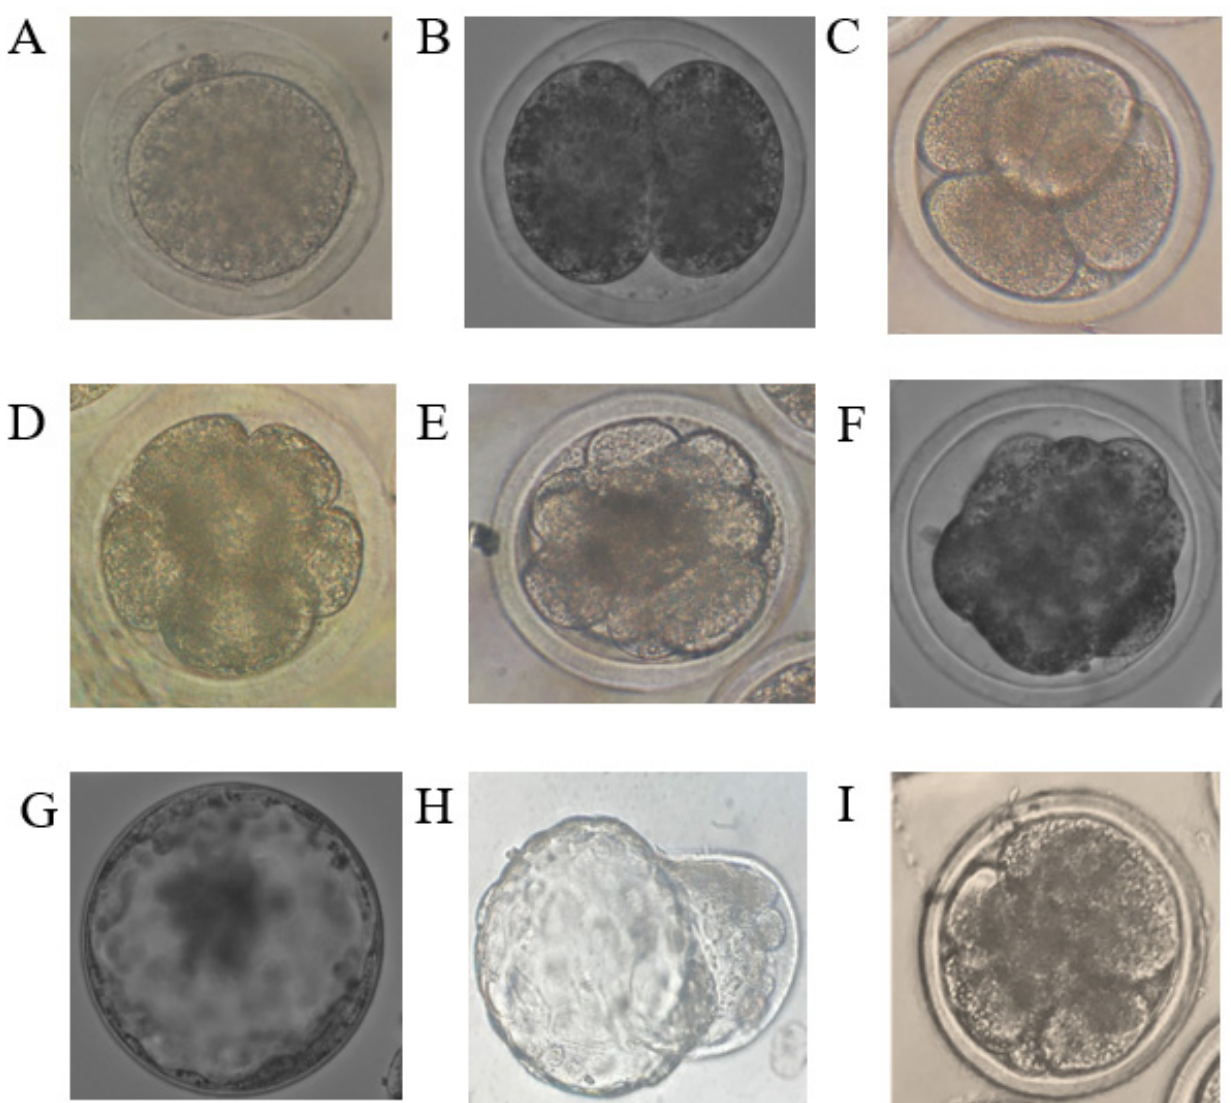
Figure 1. Images of embryos at different developmental stages obtained in the experiment. ( A ) = zygote, ( B ) = 2-cell stage, ( C ) = 4-cell stage, ( D ) = 8-cell stage, ( E ) = 16-cell stage, ( F ) = morula, ( G ) expanded blastocyst, ( H ) = hatching blastocyst, ( I ) = fragmented embryo. Table 2. The effect of the addition of O. vulgare extract on the rate of nuclear maturation of sheep oocytes matured in vitro .